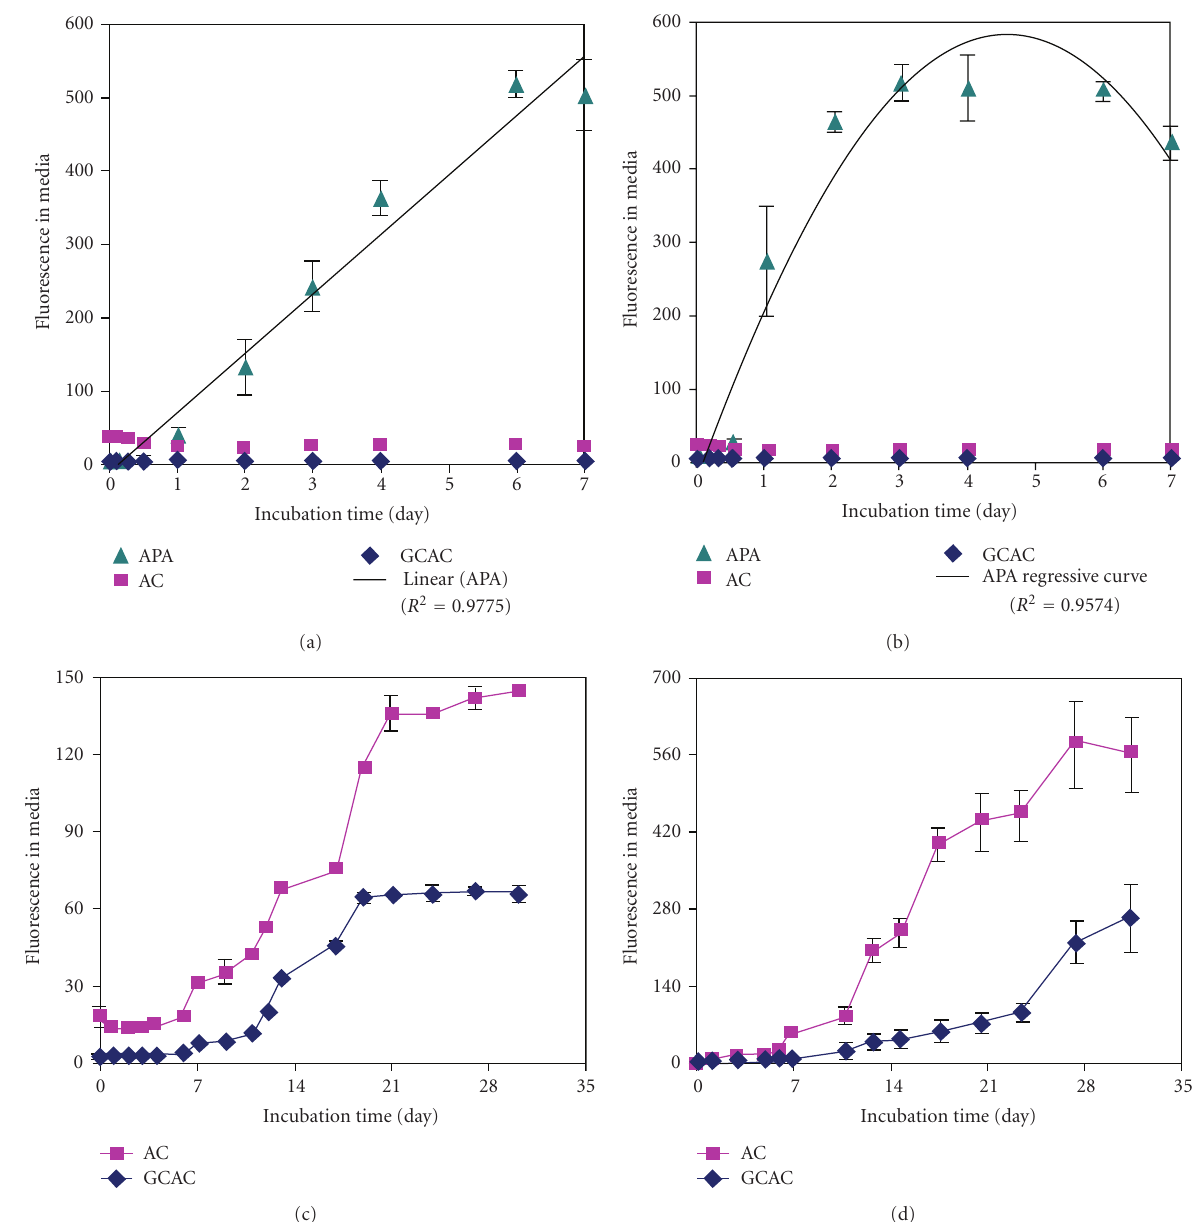
Figure 14: Leaking of the entrapped FITC-dextran (MW 2000 KD) from microcapsules incubated in lysozyme solution at the concentrations of (a): 15 μ g/mL; (b)-(c): 0.15 mg/mL; (d), 15mg/mL. Note the scale di ff erences in both x-y